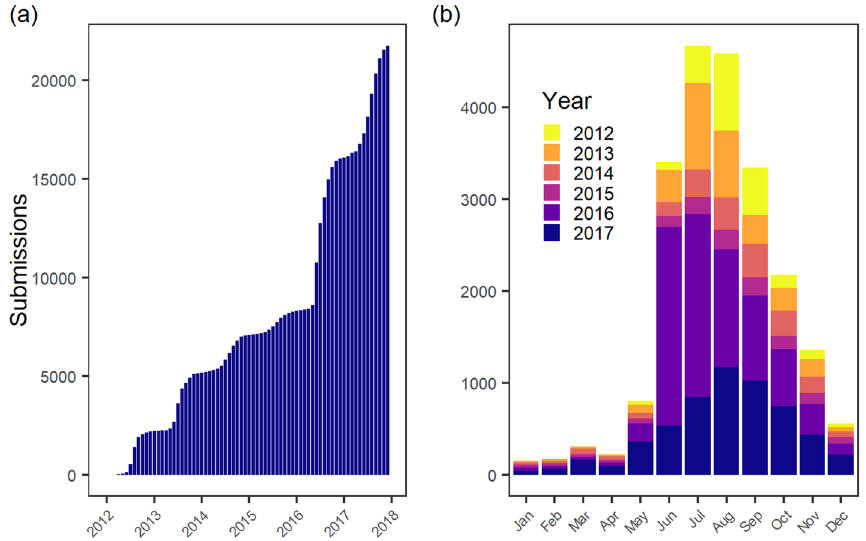
Figure 2. Temporal variation in submission numbers. ( a ) Cumulative submission numbers from 2012 to 2017. ( b ) Total number of submissions per month over all study